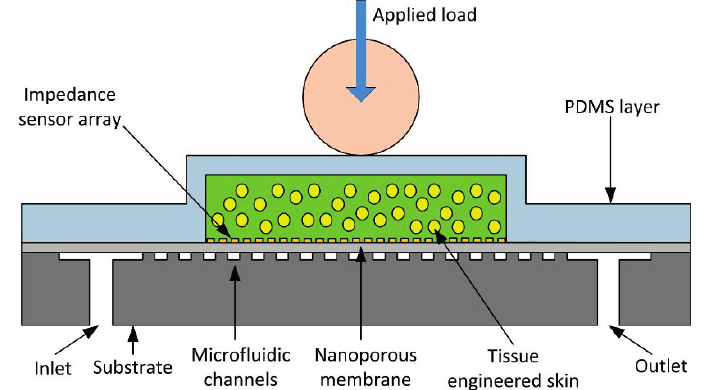
Figure 2. Cross-section of the bio-hybrid tactile sensor array. Not to